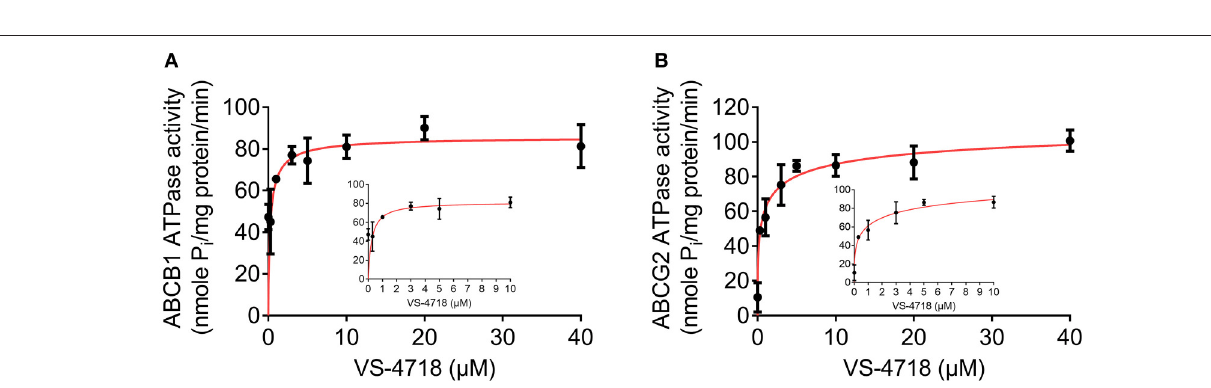
FIGURE 6 | VS-4718 stimulated the ATPase activity of ABCB1 and ABCG2. (A) Effect of VS-4718 on the ATPase activity of ABCB1. (B) Effect of VS-4718 on the ATPase activity of ABCG2. The inset graphs illustrate the effect of 0–10 µ M VS-4718 on the ATPase activity of ABCB1 (A) or ABCG2 (B) . Data are mean ± SD , representative of three independent